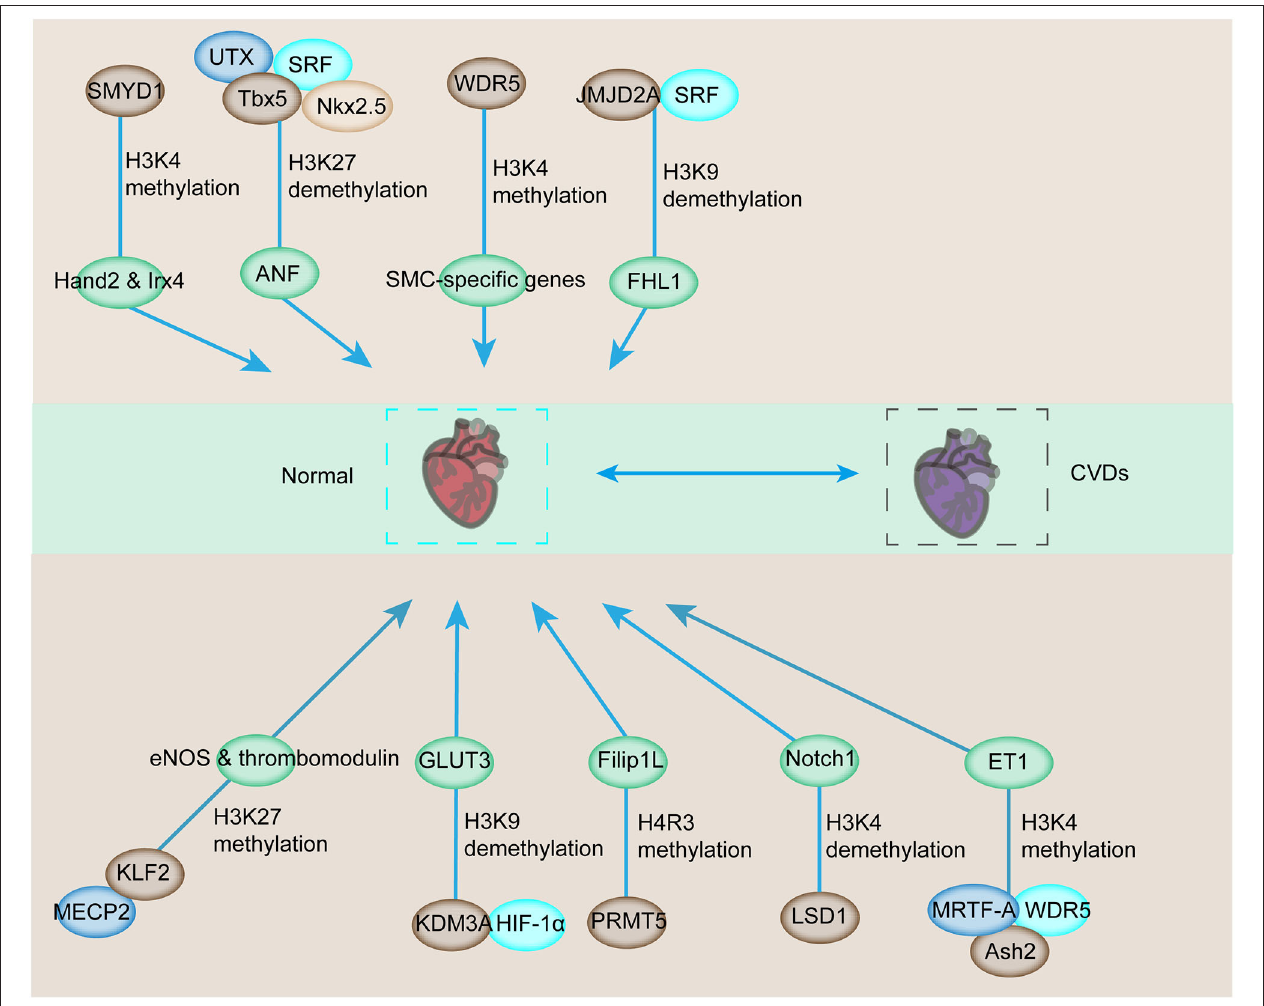
FIGURE 2 | Downstream target genes involved in cardiovascular development and CVDs are affected by histone methylation and related enzymes. The downstream genes involved in the regulation of cardiovascular development can be modulated by histone methyltransferase or demethylase for transcriptional activation or repression. The abnormal activation or repression eventually contributes to the progression of